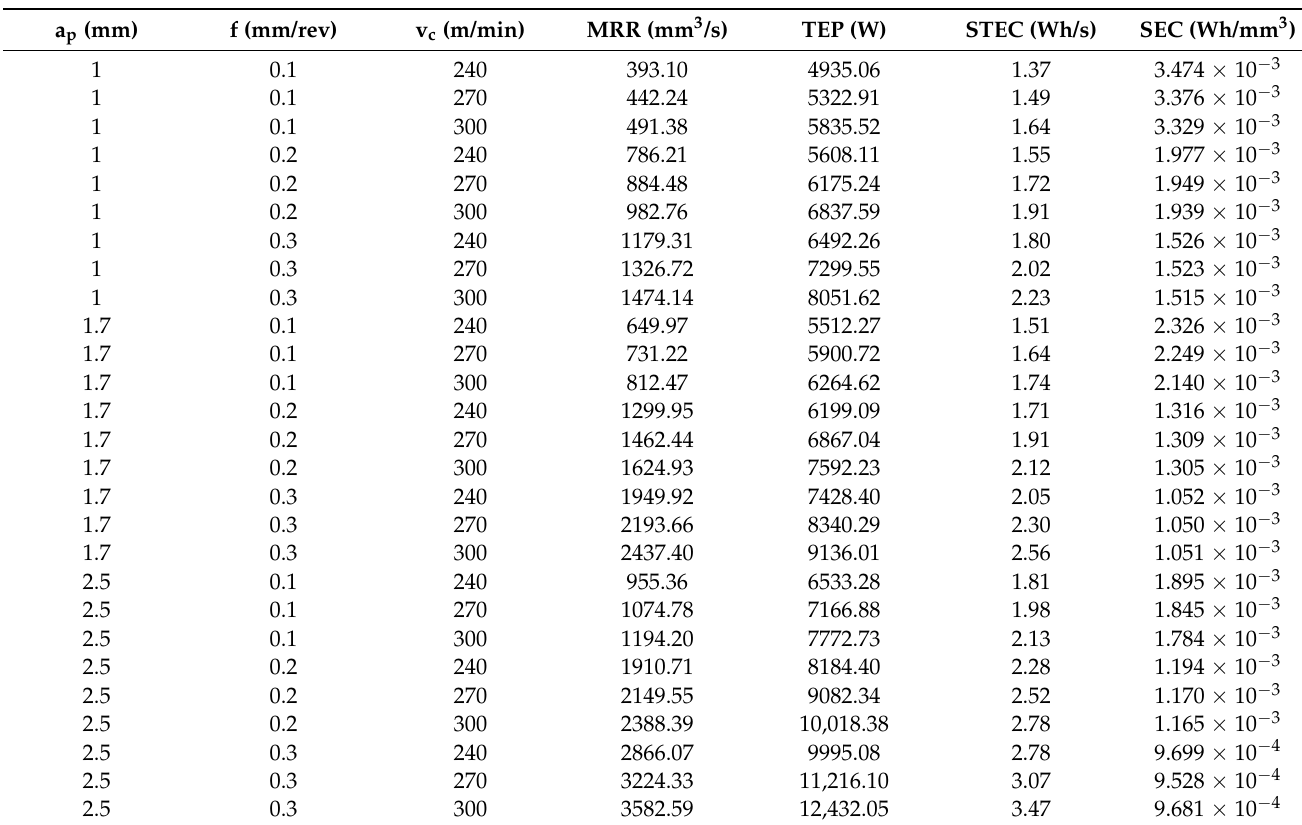
Table 4. Cutting parameter combinations and corresponding measured values of total engaged power (TEP) and time-specific total energy consumption (STEC) as well as the calculated values of material volume removal rate (MRR) and specific total energy consumption (SEC) in terms of material